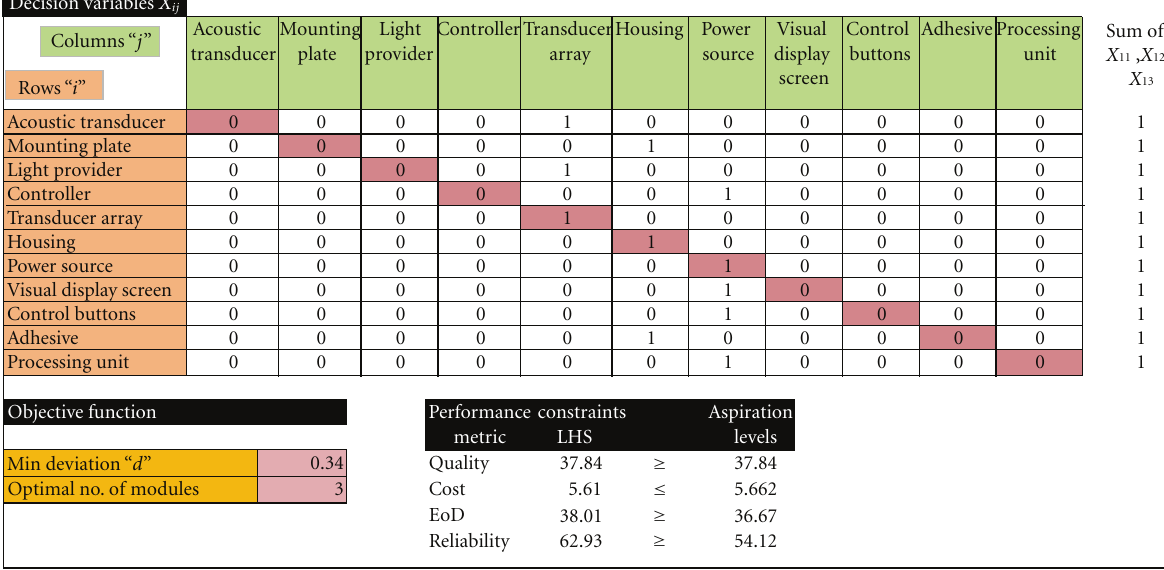
Figure 9: Final GP—optimal number of modules, N ∗ —stakeholder 2 rating.